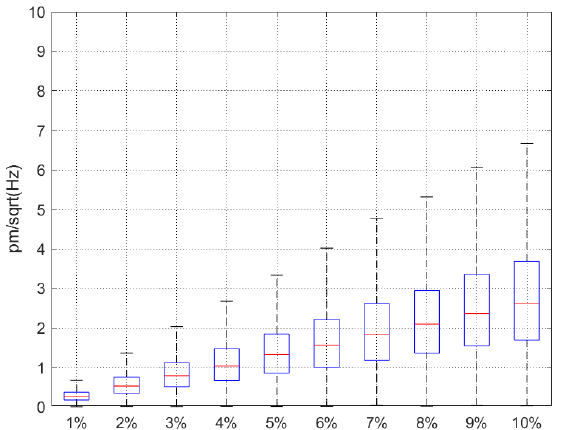
Figure 9. The box plot of phase noise with an increasing RSA ratio. Here, the top edge of the blue box is Q3 (third quartile) and the bottom is Q1 (first quartile). The red line in the middle of the box is Q2 (second quartile or median). The extension cord of the box is called the whisker, and the top of the whisker is maximum and the bottom is minimum.